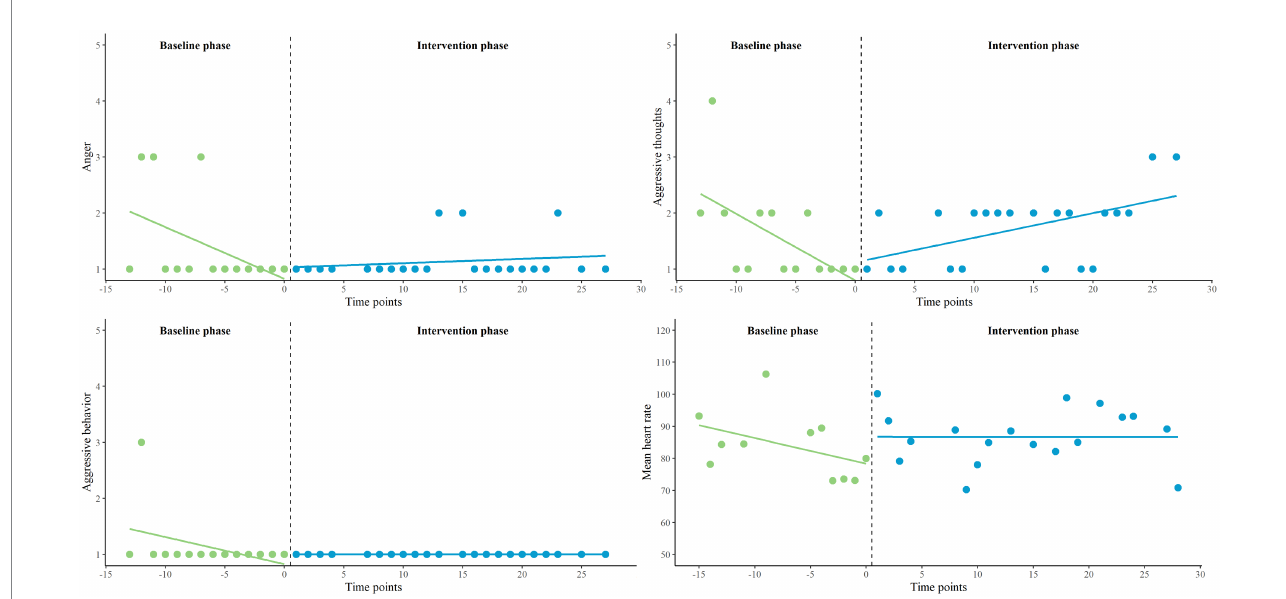
FIGURE 5 Representation of Ryan’s EMA measures (anger, aggressive thoughts and aggressive behavior) and HR (average), measured twice a day on a 5-point Likert scale, in baseline (A 1 ) and intervention phase